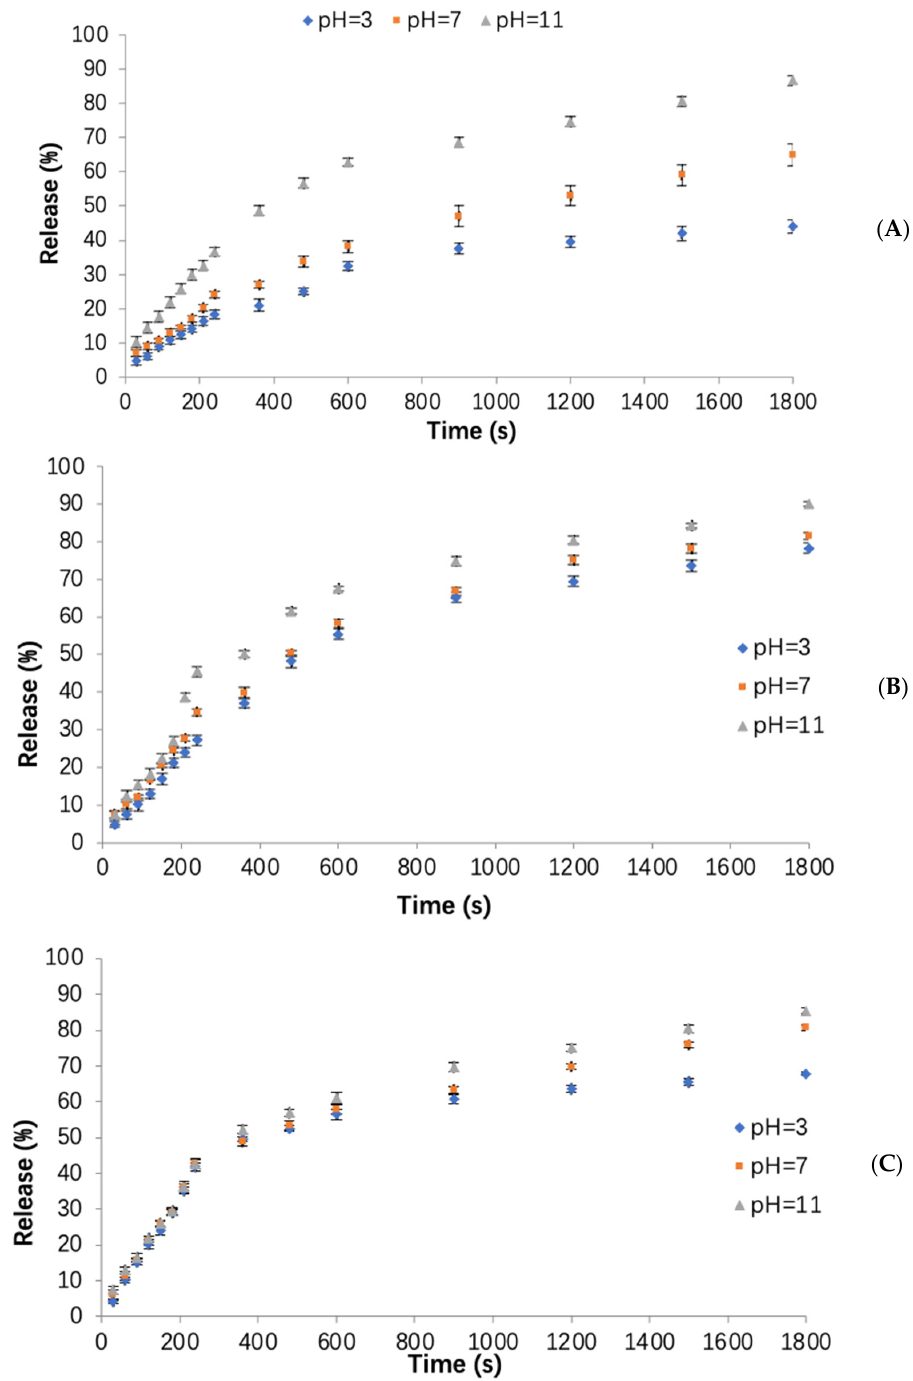
Figure 4. The release of orange peel oil from powders at 60 °C and different pH values (3, 7, 11): ( A ) NC3, ( B ) NC6, ( C ) NC9. ( A ) NC3, ( B ) NC6, ( C )